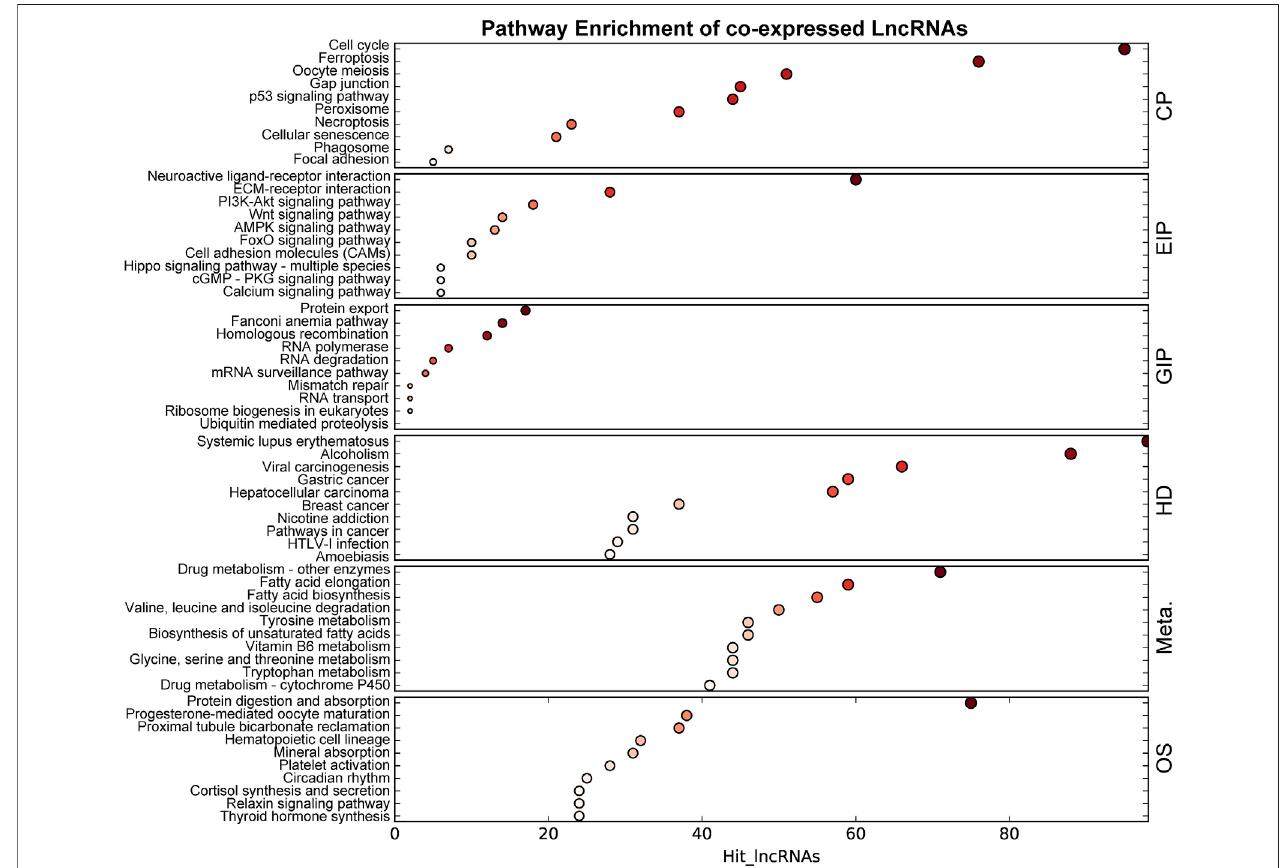
FIGURE 5 | KEGG enrichment of genes in the co-expressed network. The size of the bubble represents the number of differential genes, and the bubble ’ s color represents enriched p -value. Hit_lncRNAs indicate the number of lncRNAs with co-expressed mRNAs. KEGG level 1 category included cellular processes (CP), environmental information processing (EIP), genetic information processing (GIP), human diseases (HD), metabolism (Meta.), and organismal systems